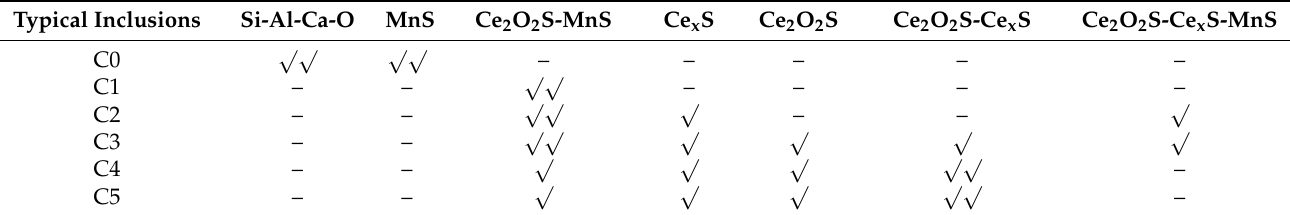
Table 3. Types of inclusions in different heats.